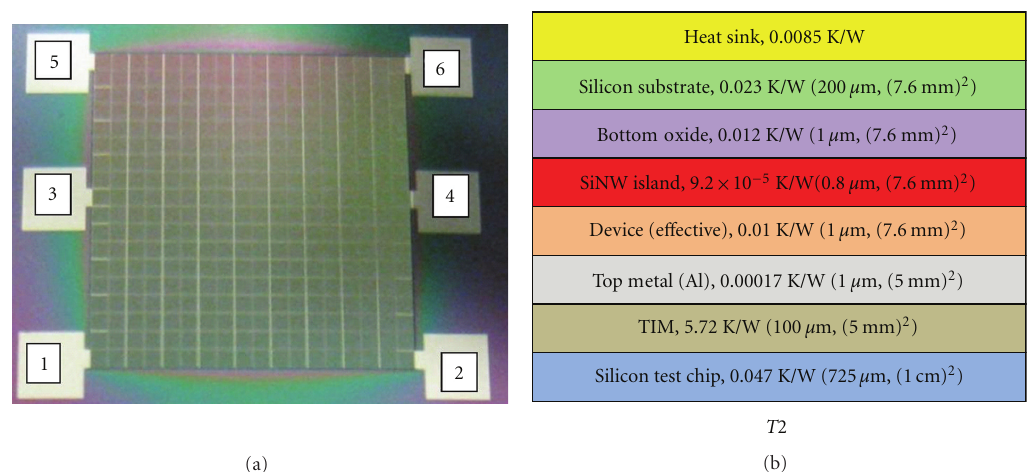
Figure 24: (a) Snapshot of the completed TEG (6 pads at the sides of the TEG to allow connections of di ff erent areas). Connecting the terminals 1 and 5 establishes an ohmic path between several serpentine P- and N-elements in a 5 mm × 5mm area. (b) Di ff erent layers used in the experimental setup. Indicated in the di ff erent layers is the thermal resistance used in the calculations. The heat sink thermal resistance calculation is based on Al with a dimension of 5cm × 5 cm × 5 mm. (Reprinted with permission from [70]. [2011] IEEE.)